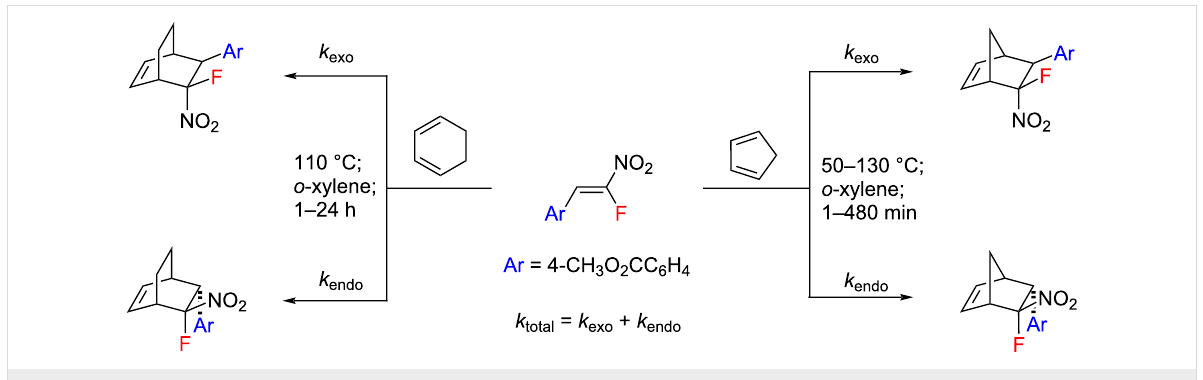
Scheme 4: Kinetic study of reactions of 1h with CPD and CHD.